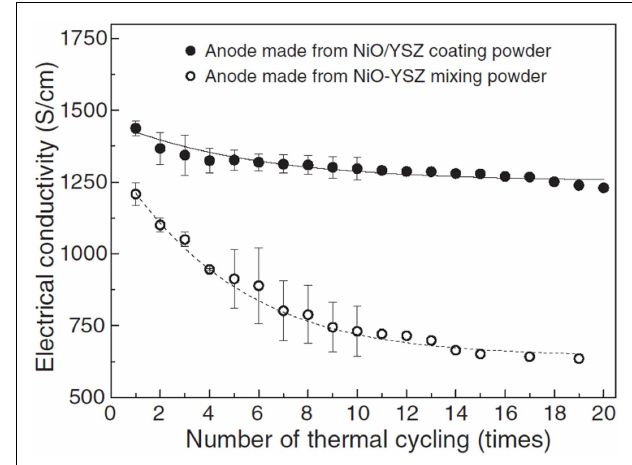
FIGURE 2 | Electrical conductivity variations of anodes depending on thermal cycling (Kim et al., 2006) . Reprinted with permission from Elsevier.